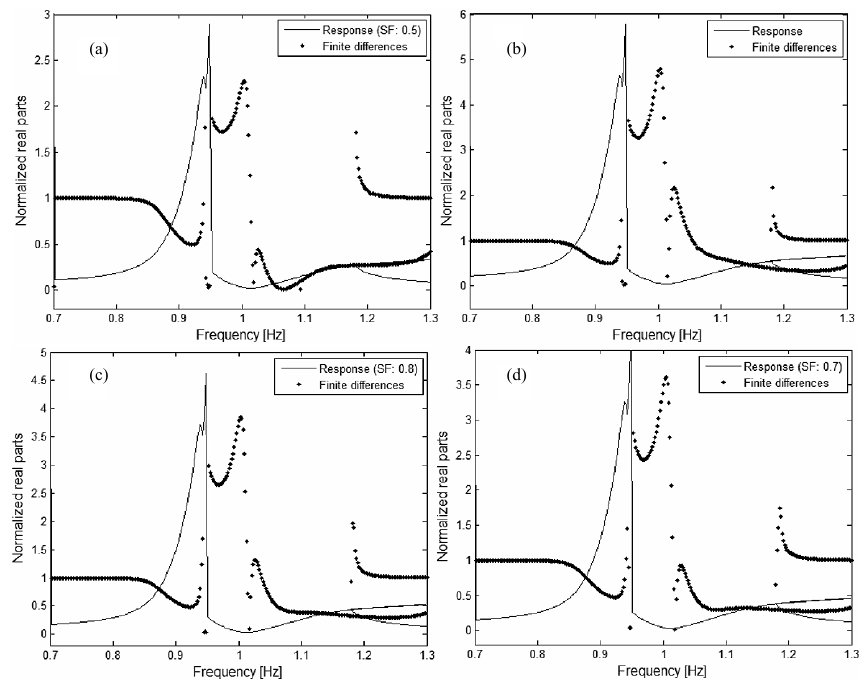
Fig. 7. Finite difference estimations of the Response H ( ω,p ) with respect to β : (a) ∆ β / β = 1%; (b) ∆ β / β = 5%; (c) ∆ β / β = 10%; (d) ∆ β / β =